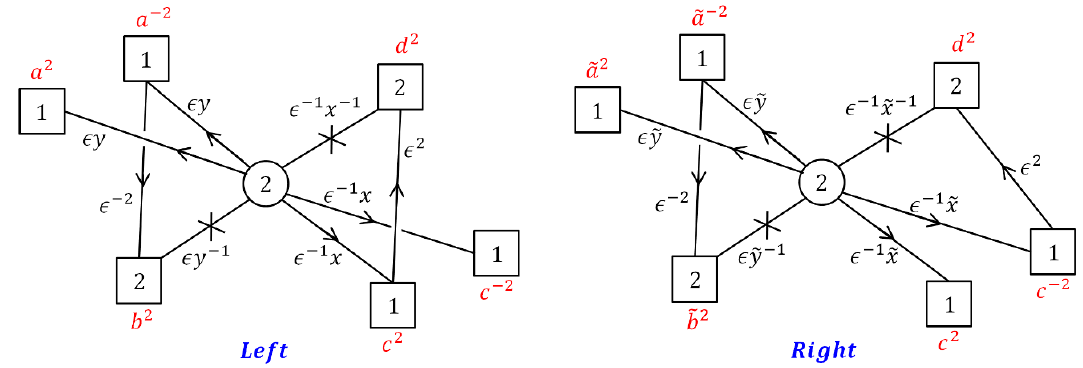
Figure 24 . Decomposition of the trinion into left and right part. The two parts are glued with superpotential which identi(cid:12)es the symmetries as indicated. We will study Seiberg duality sequences of each half. Note the two halves are almost identical modulo di(cid:11)erent gauge singlet (cid:12)elds charged under c and d symmetries. R-charges of gauge singlet (cid:12)elds are 1 and (cid:12)elds transforming under the gauge SU(2) have R charge 1 2